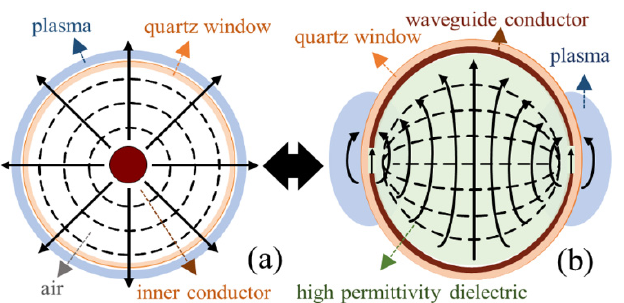
Figure 1. Field lines at radial cross-section for quasi-coaxial TEM and circular TE 11 waveguiding structure. ( a ) Quasi-coaxial TEM linear MWP and ( b ) circular TE 11 waveguiding structure.